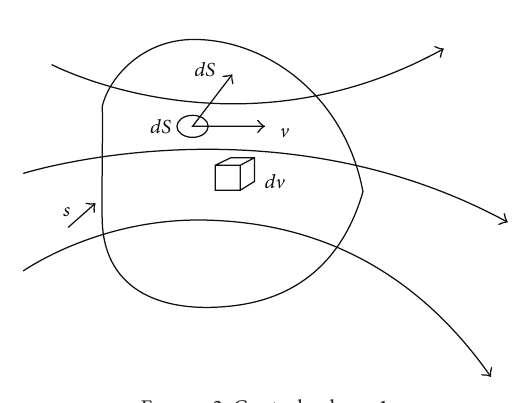
Figure 1: The two-phase flow.